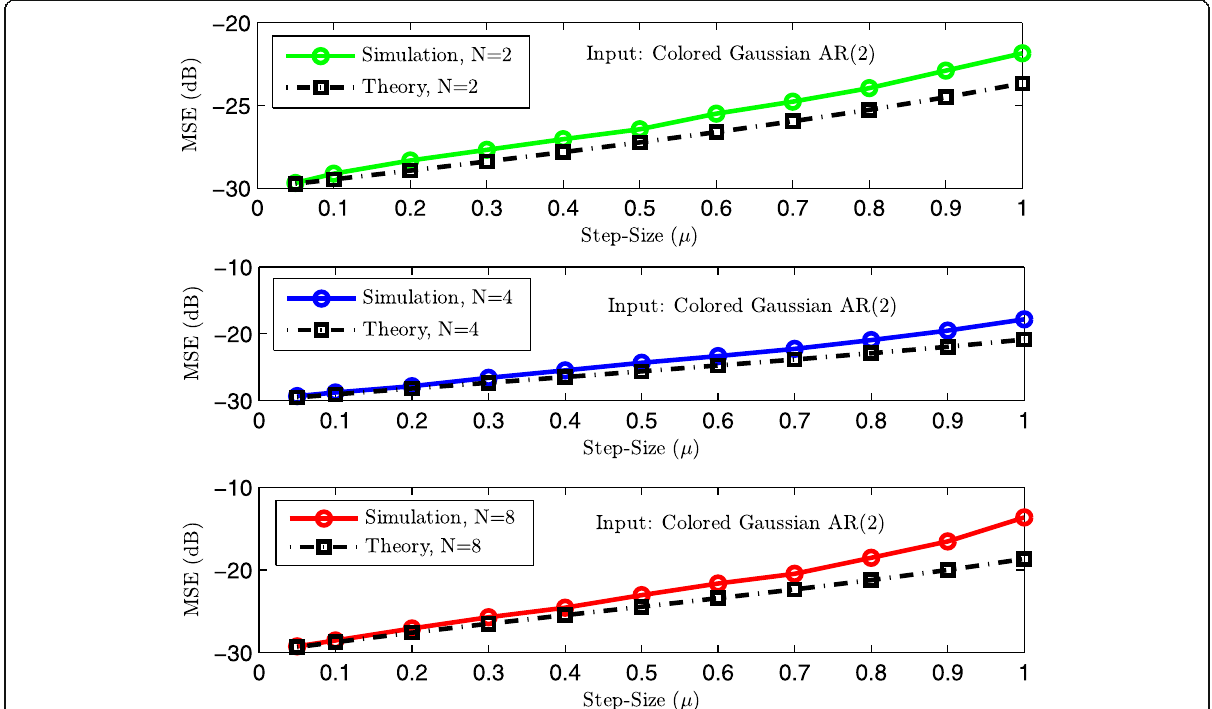
Fig. 27 Simulated and theoretical steady-state MSE of MSR-NSAF with N = 2, 4, and 8 as a function of the